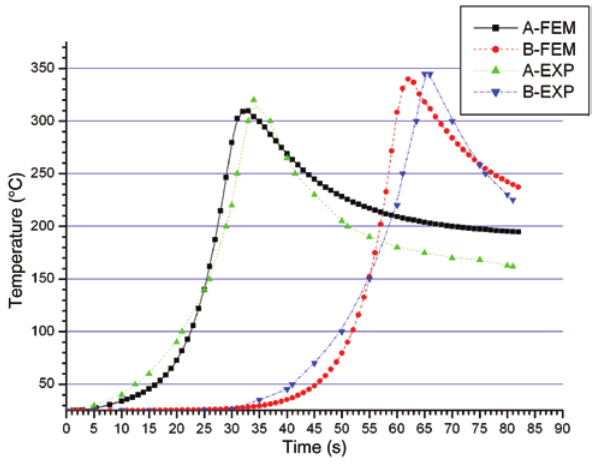
Figure 11: Calculated and measured temperatures at typical meas- uring